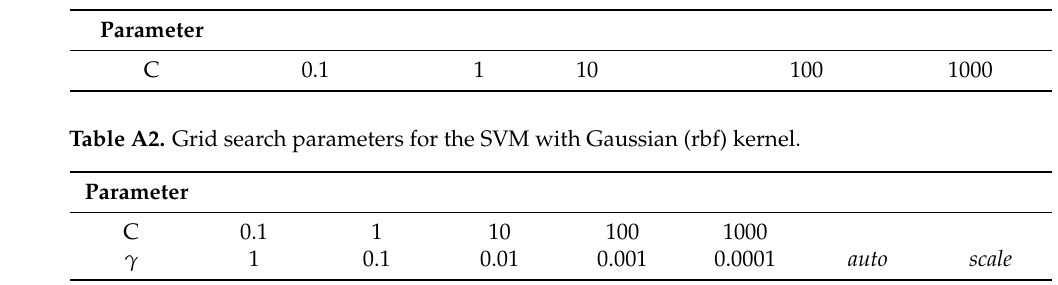
Table A1. Grid search parameters for the SVM with linear kernel.